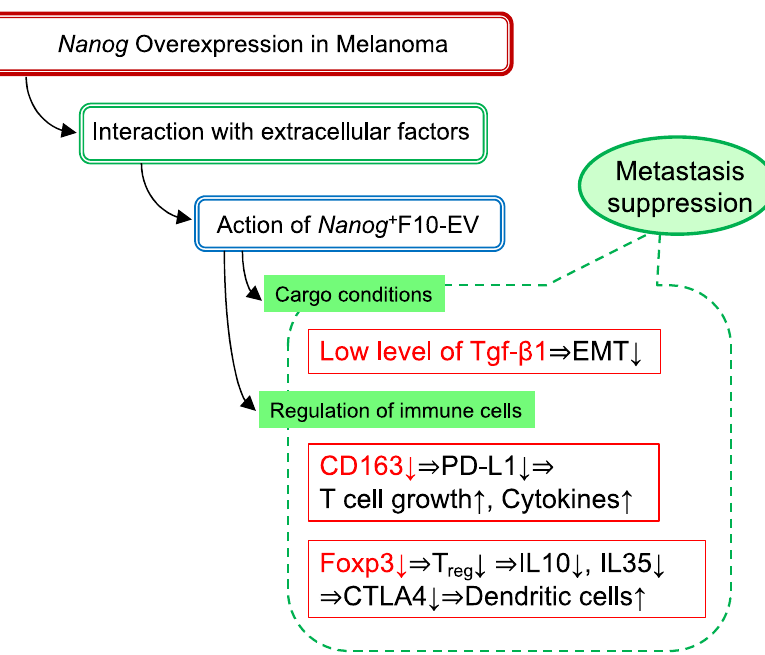
Figure 7. A postulated mechanism of metastasis-suppressive effects by Nanog + F10-EV.